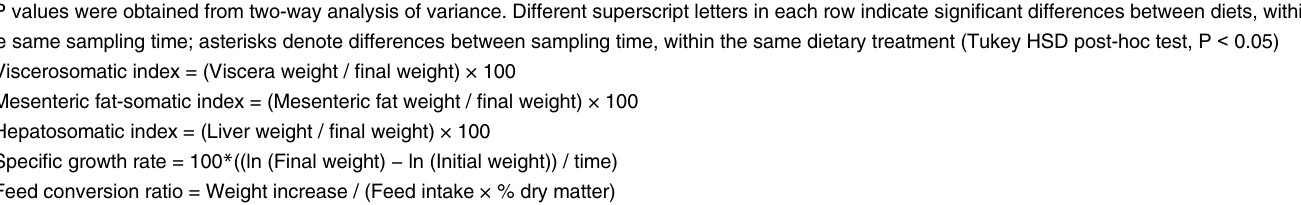
1 P values were obtained from two-way analysis of variance. Different superscript letters in each row indicate signi fi cant differences between diets, within